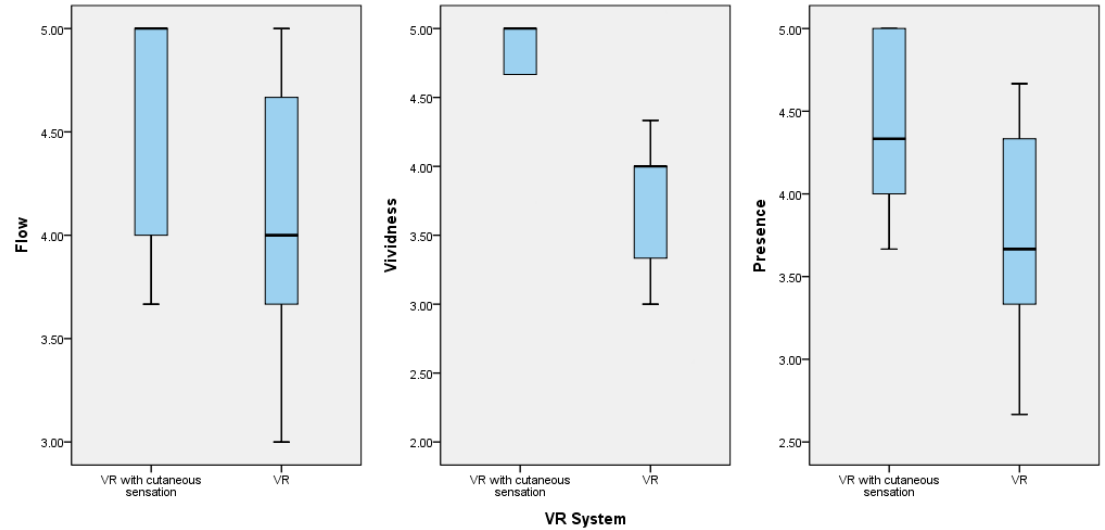
Table 7. Results of the Mann–Whitney U test analysis for the variables of the high-anxiety group while playing the fire safety education VR game with cutaneous sensation and the group that played the basic fire safety education VR game.